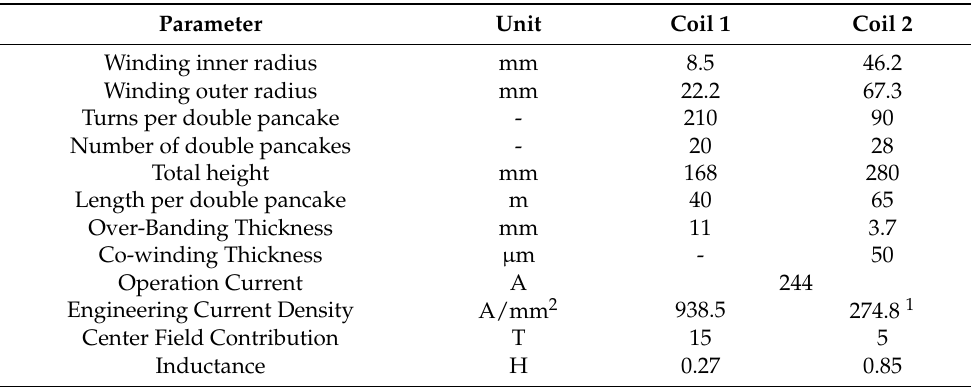
Table 2. Key Parameters of 20 T Insert